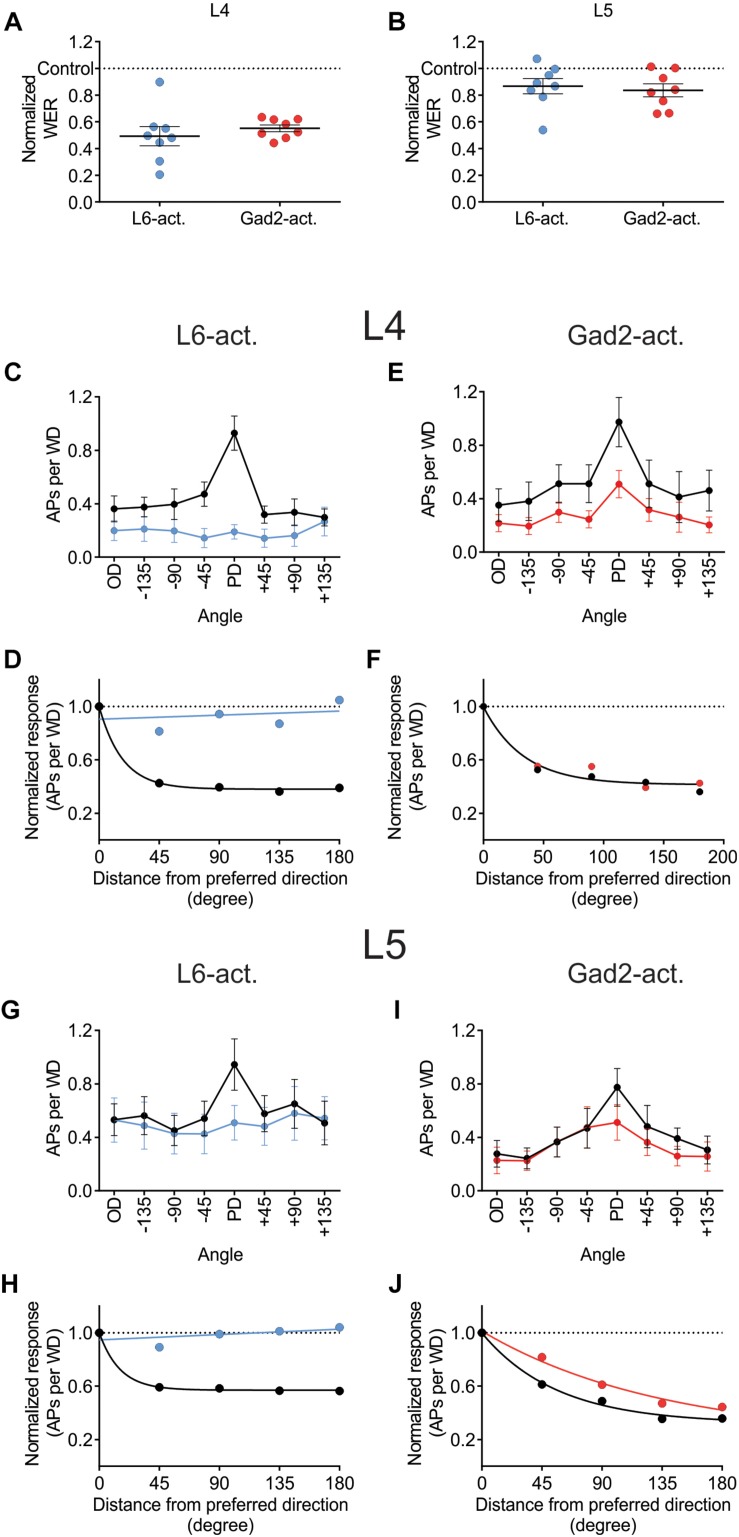
Different effect on angular tuning depending on which GABAergic circuit that is activated. (A,B) Normalized decrease of the WER (the WER in control is 1) with photo-activation of L6-Ntsr1 cells or GABAergic interneurons. On average (averaged over all eight directions) the photo-activation decreased the WER with the same strength for both layers in both mouse lines [L4: L6-Ntsr1 act. Vs. Gad2-act., t(14) = 0.7674, p = 0.4556, unpaired t-test; L5: L6-Ntsr1 act vs. Gad2-act., t(14) = 0.4179, p = 0.6824, unpaired t-test]. One data point for each of the eight directions. Number of cells, is for all panels in Figure 4: L4: Ntsr1: n = 13, Gad2: n = 12; L5: Ntsr1: n = 12, Gad2: n = 12. (C) Averaged WER for L4 excitatory cells in Ntsr1-cre animals. In the L6-Ntsr1 condition, the WER is independent of the whisker deflection direction [interaction: F(7,84) = 9.085, p < 0.0001; two-way ANOVA with repeated measures on both factors; a test for interaction that is statistically significant, indicates that the effect of the treatment (difference between control and light activation) differs between whisker deflection angles]. (D) A different way to show the result from (C), is to plot the same data as normalized whisker-evoked response (WER) with distance (in degrees) from the preferred direction (set at 0°). Direction selectivity index (DSI; see Materials and Methods) for control condition is 3.57 and with L6-Ntsr1 activation zero. (E) Averaged WER for layer 4 excitatory cells in Gad2 animals for each condition and each direction. Interaction: F(7,77) = 1.215, p = 0.3046; two-way ANOVA with repeated measures on both factors. The lack of interaction indicates that light activation affects the WER similarly for all whisker deflection angles. (F) Progression of the normalized WER with distance (in degree) from the preferred direction. DSI = 1.75 for both conditions. (G) Averaged WER for L5 excitatory cells in Ntsr1 animals for each condition and each direction. In the L6-Ntsr1 activation condition, the WER decreased more for the PD compared to all other directions [interaction: F(7,77) = 2.134, p = 0.0497; two-way ANOVA with repeated measures on both factors]. (H) Normalized WER plotted against distance (in degree) from the preferred direction. DSI control = 2.80, DSI L6-Ntsr1 act. = zero. (I) Averaged WER for L5 excitatory cells in Gad2 animals for each conditions and each direction [Interaction: F(7,77) = 2.375, p = 0.0298; two-way ANOVA with repeated measures on both factors]. (J) Progression of the normalized WER with distance (in degree) from the preferred direction. DSI control = 1.20; DSI Gad2-act. = 0.59.